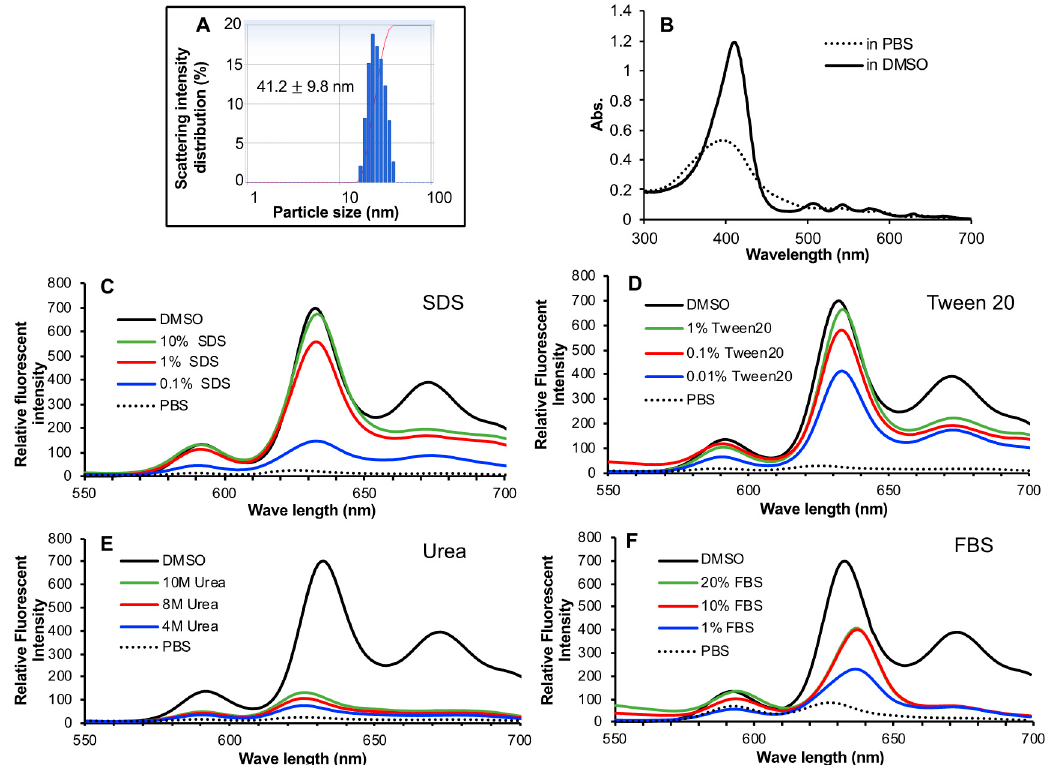
Figure 2. Micelle formation of HA-es-ZnPP. HA-es-ZnPP showed a hydrodynamic diameter in physiological saline of 41.2 nm, as measured by DLS ( A ). The micelle formation was supported by decreased absorbance as seen in UV/vis spectra ( B ), and more importantly, fluorescence quenching, the fluorescence intensity of HA-es-ZnPP in PBS was almost undetectable compared to that in DMSO ( C , D ). The micelle formation could be effectively disrupted by detergent SDS ( C ) and Tween 20 ( D ), as evidenced by increased fluorescence, but it could not be affected by urea ( E ). Increased fluorescence intensity/disruption of micelles was also found in the presence of FBS ( F ). See text for details.